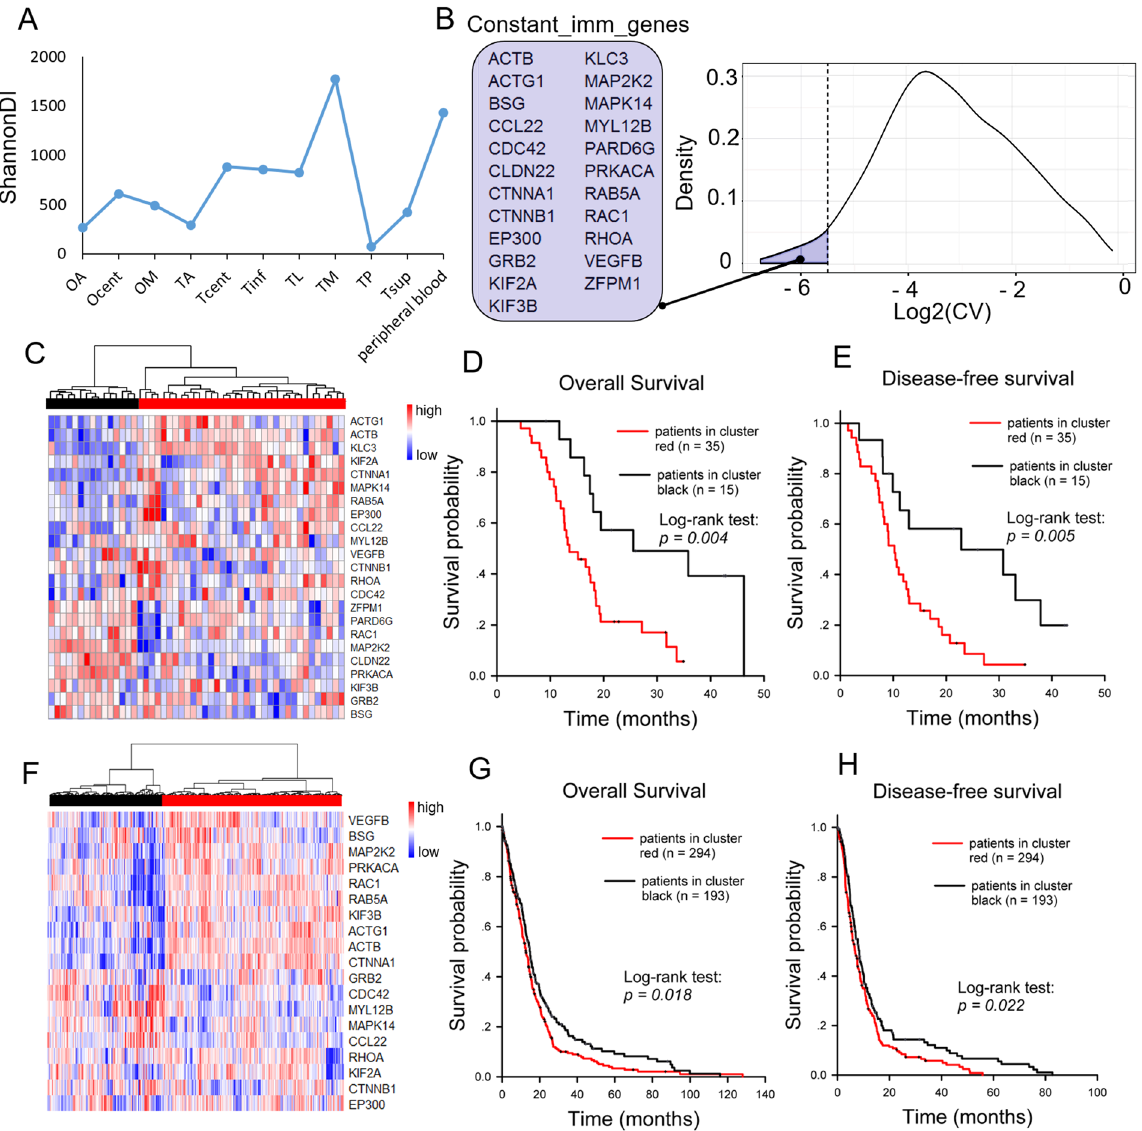
Figure 5. Discovery of the Constant_imm_genes and validation of their clinical prognostic significance. ( A ) ShannonDI of the samples. ( B ) The right panel shows the log2-transformed CV of the expression level of genes belonging to the pathways listed in Table 1. The dotted line indicates the selected cut-off threshold of − 5.5, which defines the Constant_imm_genes listed in the left panel. ( C ) Fifty GBM patients were classified into two major groups (red and black clusters) by unsupervised hierarchical clustering according to the expression pattern of the Constant_imm_genes. The expression levels of these genes are illustrated as a color spectrum, with red, white and blue representing high, medium and low expression, respectively. Kaplan-Meier survival curves and log-rank tests were used to estimate the overall survival ( D ) and disease-free survival ( E ) of the two clusters of patients. A similar analysis was applied to the public TCGA GBM datasets, and the results are shown in panels ( F – H